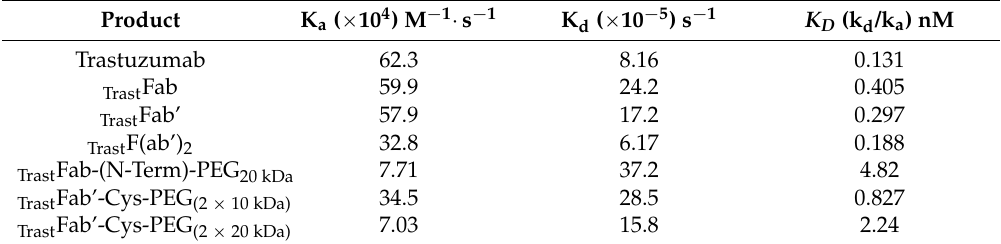
Table 3. Average of kinetic parameters and apparent affinity constants of Trastuzumab and Fab derivatives obtained by surface plasmon resonance (SPR) technique using CM5 Chips with Immobilized